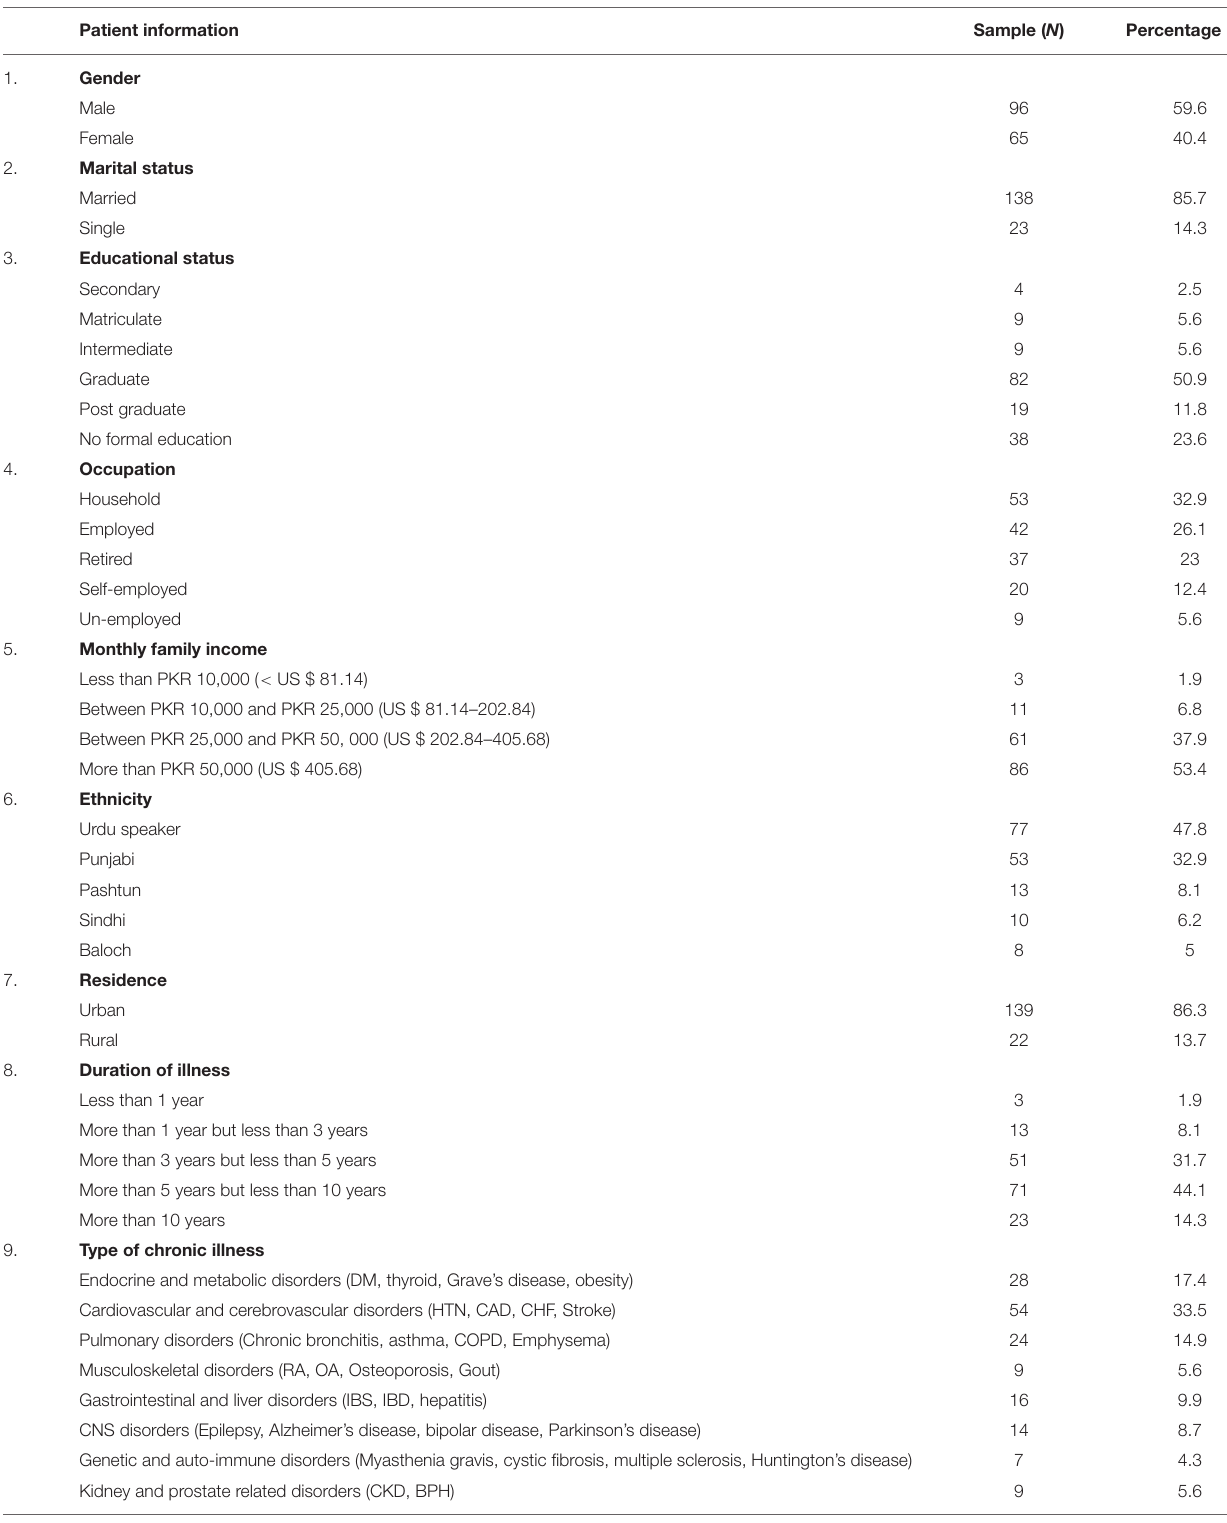
TABLE 2 | Demographic information of